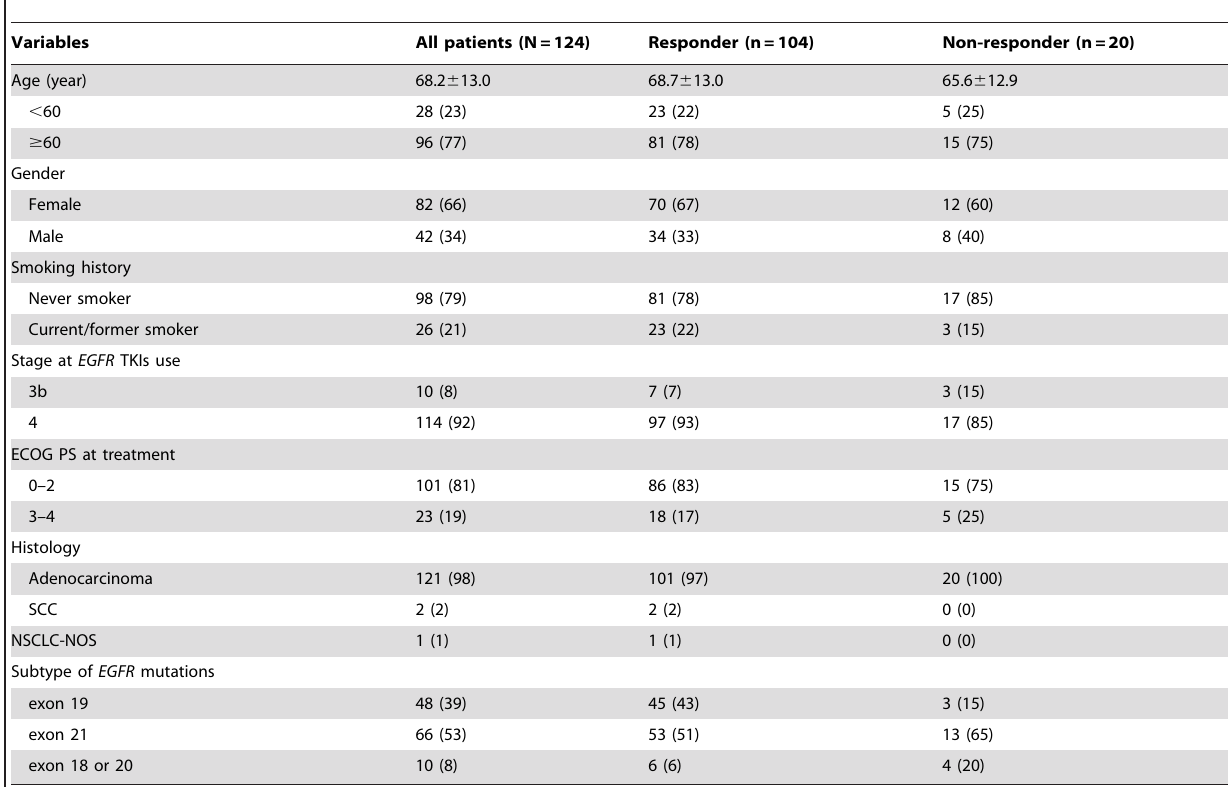
Table 1. Baseline characteristics of patients with NSCLC harboring EGFR mutations treated with EGFR